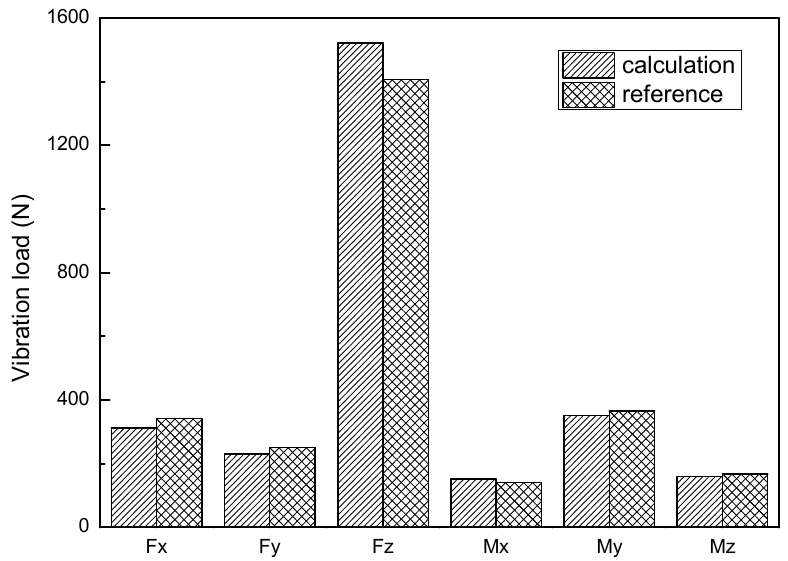
Figure 6. A comparison of calculated vibration load values with reference values.